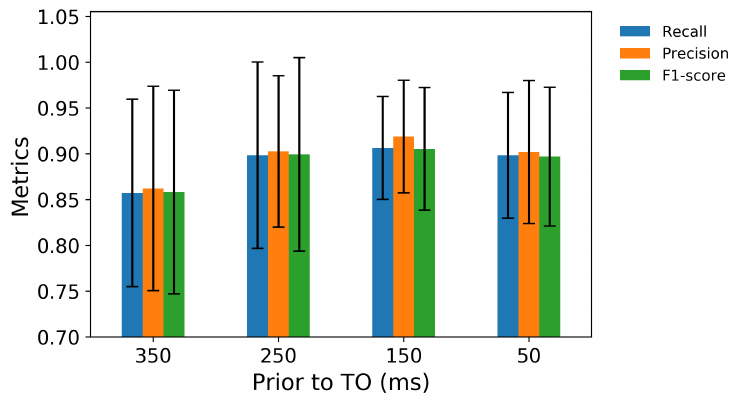
Figure 6. The precision, recall, and F1-score for predictions of transitions from level-ground walking 50ms prior to TO.